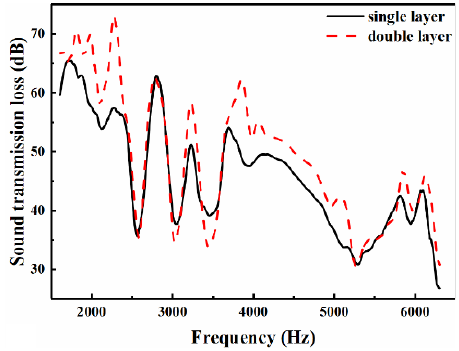
Figure 16. Test results for single-and double-layered honeycomb sandwich structures.